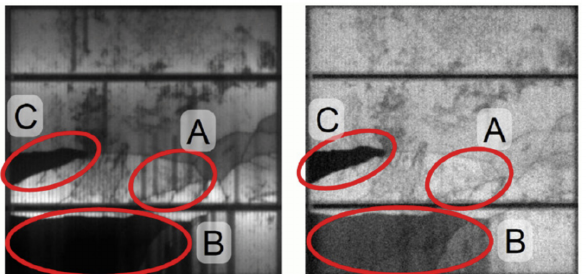
Figure 13. Electroluminescence microcrack modes A, B, and C (Reprinted from Solar Energy Materials and Solar Cells, Vol 95, issue 4, Kntges, M., Kunze, I., Kajari-Schrder, S., Breitenmoser, X., Bjørneklett,